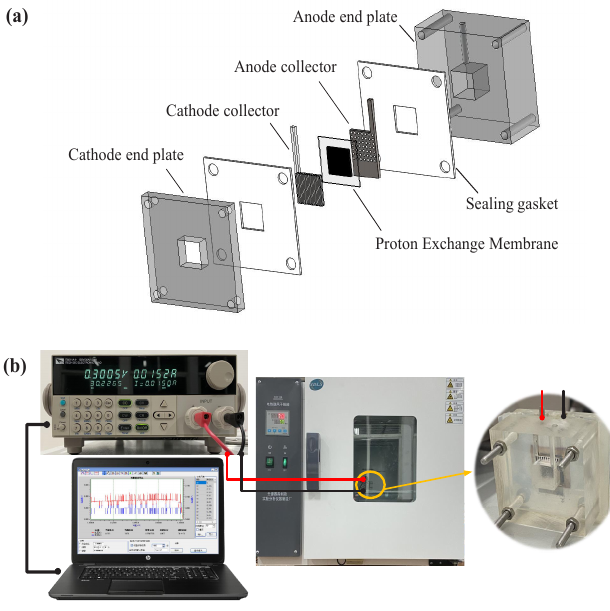
Figure 1. µ DMFC aging test: ( a ) Schematic diagram of µ DMFC structure; ( b ) µ DMFC testing platform. The end plates are made of acrylic, and the anode end plate is 40 × 40 × 20 mm 3 , with a 10 × 10 × 10 mm 3 reservoir to store the reactants. The cathode end plate is 40 × 40 × 5 mm